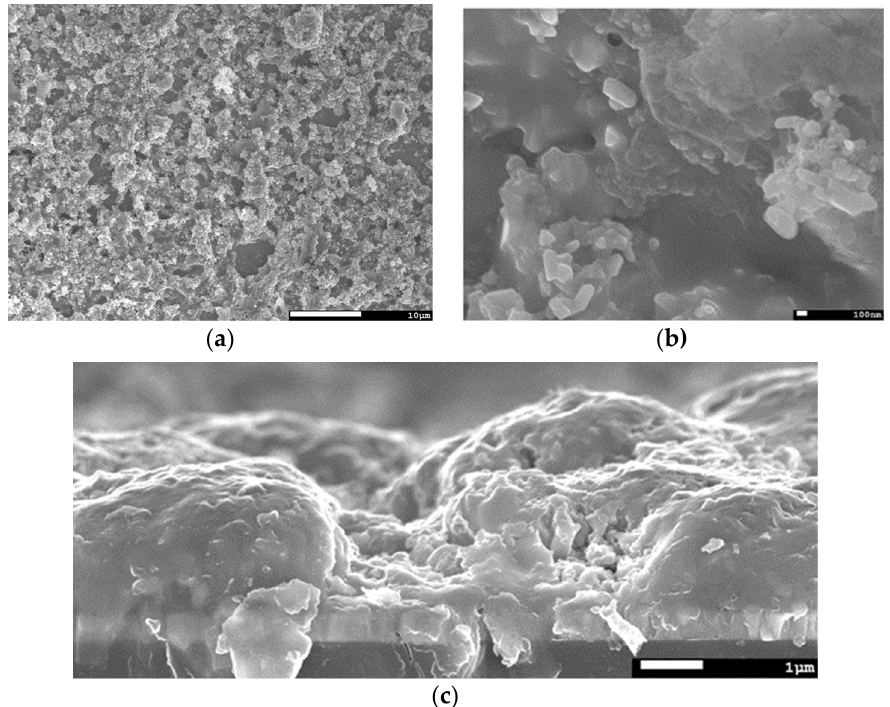
Figure 3. ( a ) SEM top view of a CISe‐film from Cu‐In + Se nanoparticle precursor after face‐to‐face annealing at 550 °C for 5 min with 46.1 kN/m² pressure shows a homogenous, but rough surface with a hole. ( b ) Higher magnification image of the same sample shows well sintered grains. ( c ) Cross-section image of the same sample shows a 3 µm dense layer with a hole to the back‐contact.